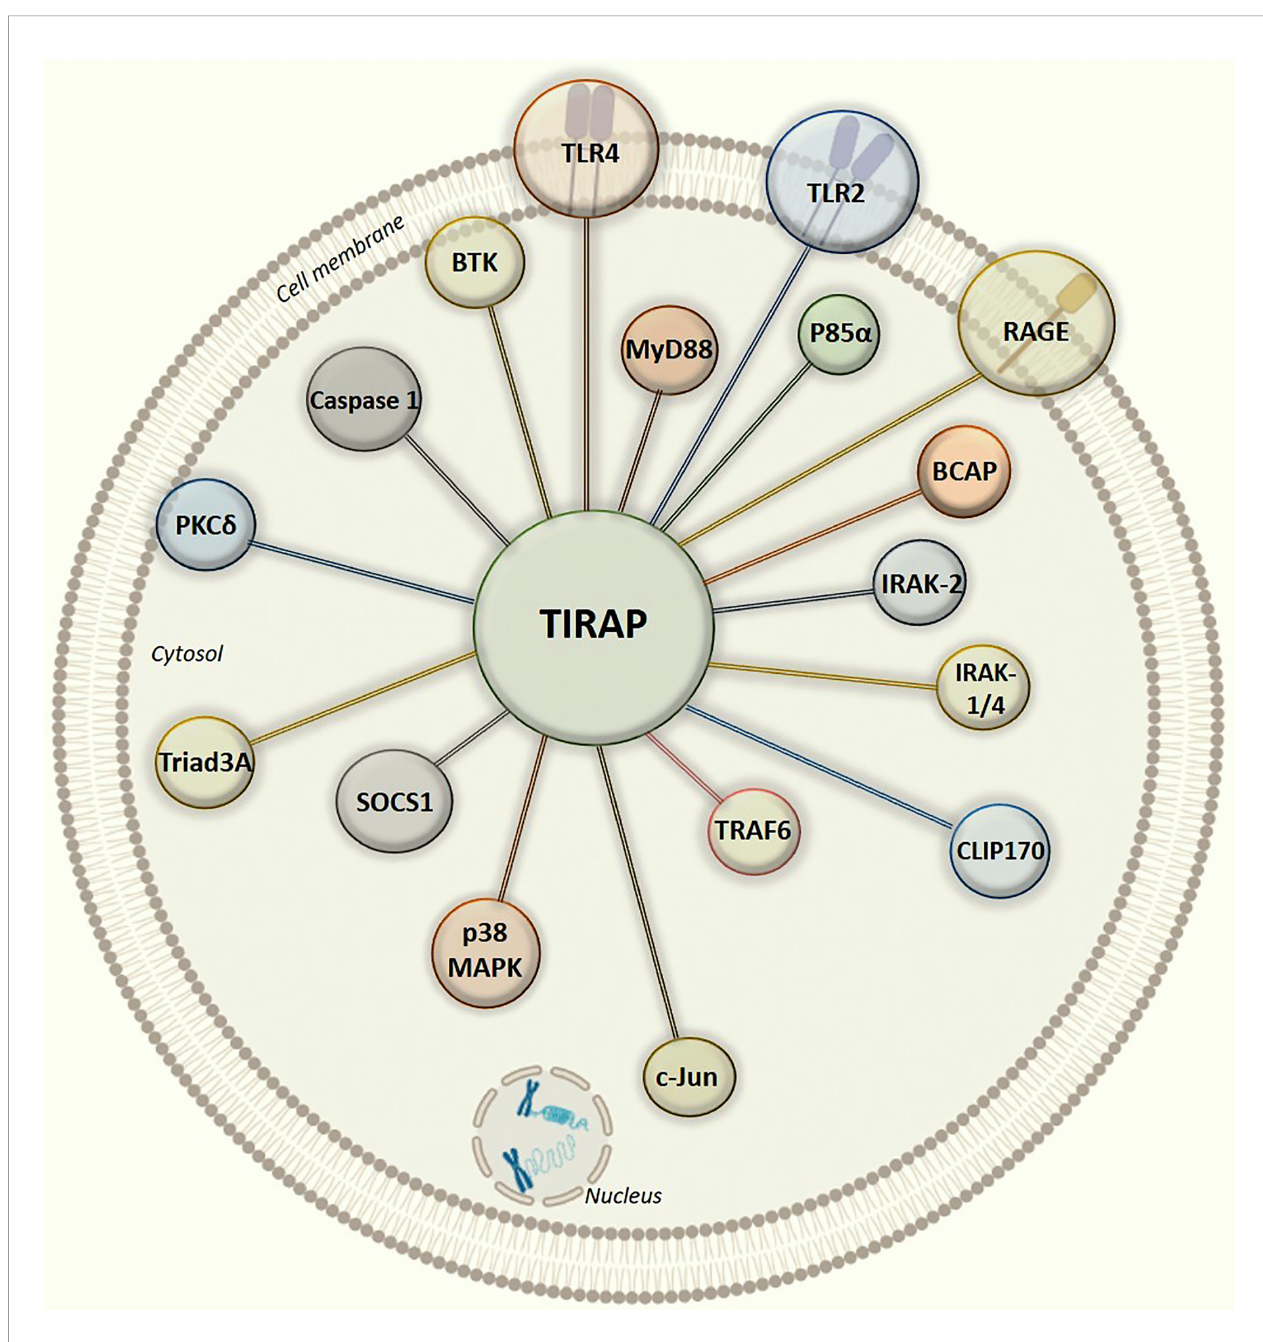
FIGURE 3 | Graphical illustration of intracellular protein-protein interaction network of TIRAP with experimentally de fi ned partner